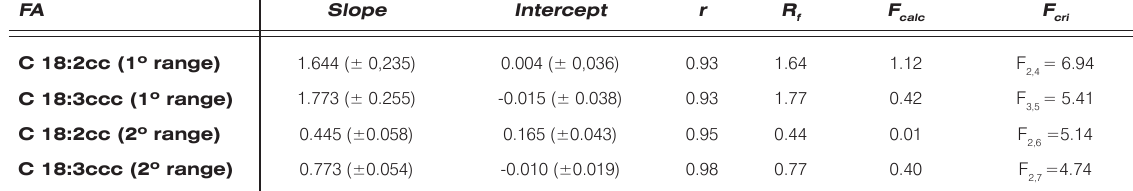
Table 3. Response Factor calculated for each FA.